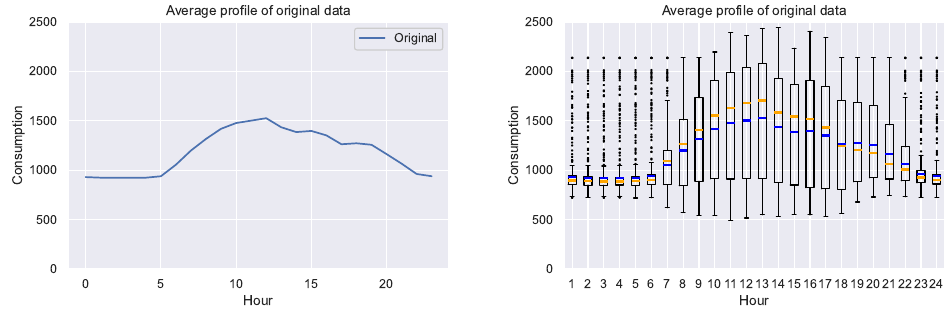
Figure 1. Average profile and corresponding box plots in kWh. Blue: mean. Orange: